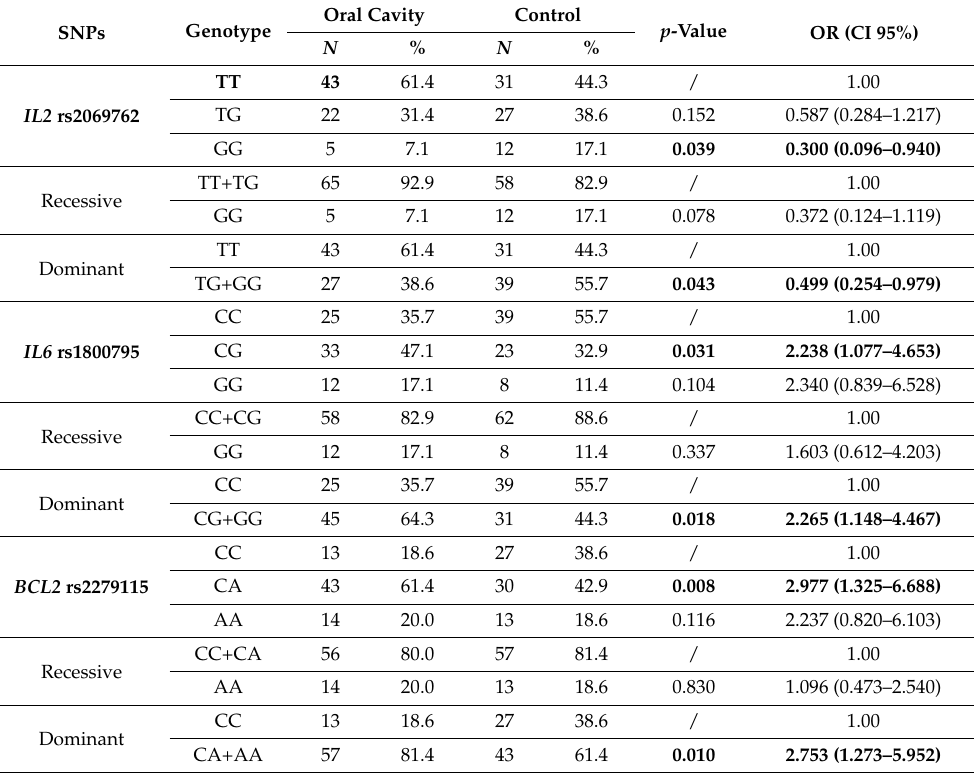
Table 3. Statistically significant SNPs in oral cavity